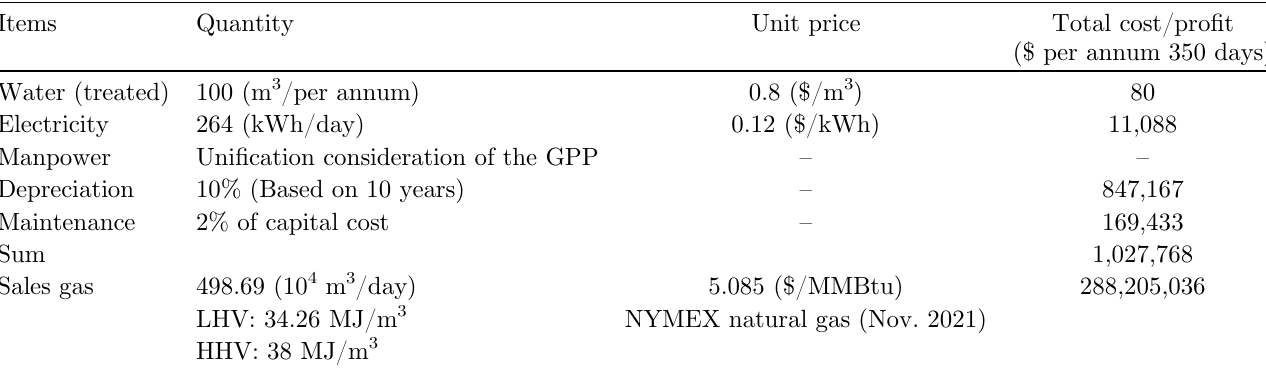
Table 7. Operating costs and product pro fi t for each dew point control